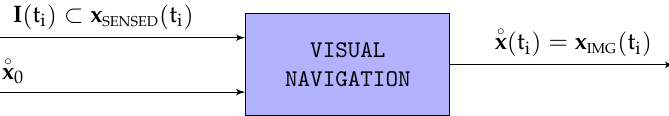
Figure 6. VNS flow diagram.